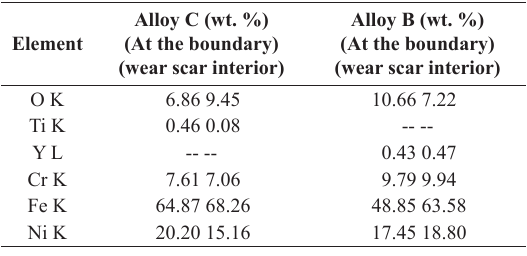
Table 4: EDS analysis results of alloy C and alloy B wear scar region. Alloy C (wt. %) Element (At the boundary) (wear scar interior)